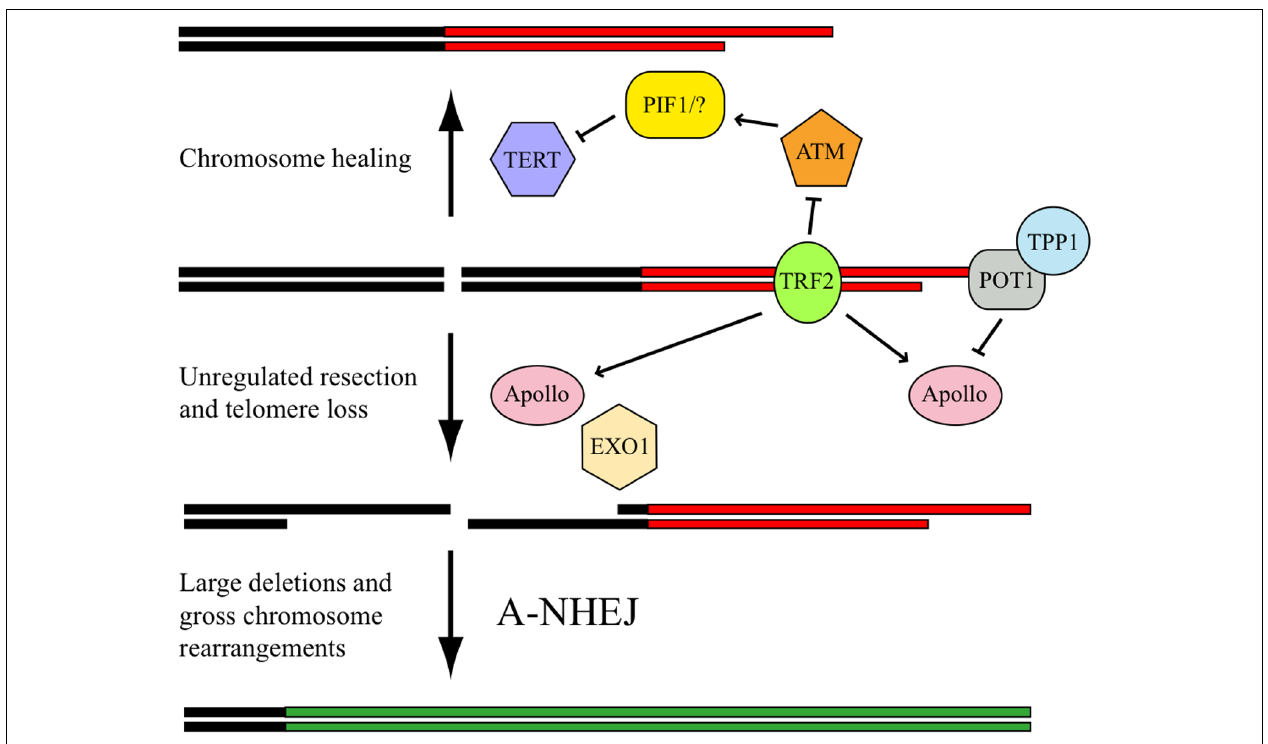
generation of single-stranded 3 (cid:2) overhangs required for telomere formation. However, unlike telomeres (red horizontal lines), in which resection is limited by POT1/TPP1 binding to the single-stranded telomeric DNA, resection of DSBs in subtelomeric regions (black horizontal lines) continues unabated due to the inability of POT1/TPP1 to bind to non-telomeric DNA.The inappropriate processing of the DSB results in large deletions and/or GCRs with other chromosomes (green horizontal lines) through a mechanism